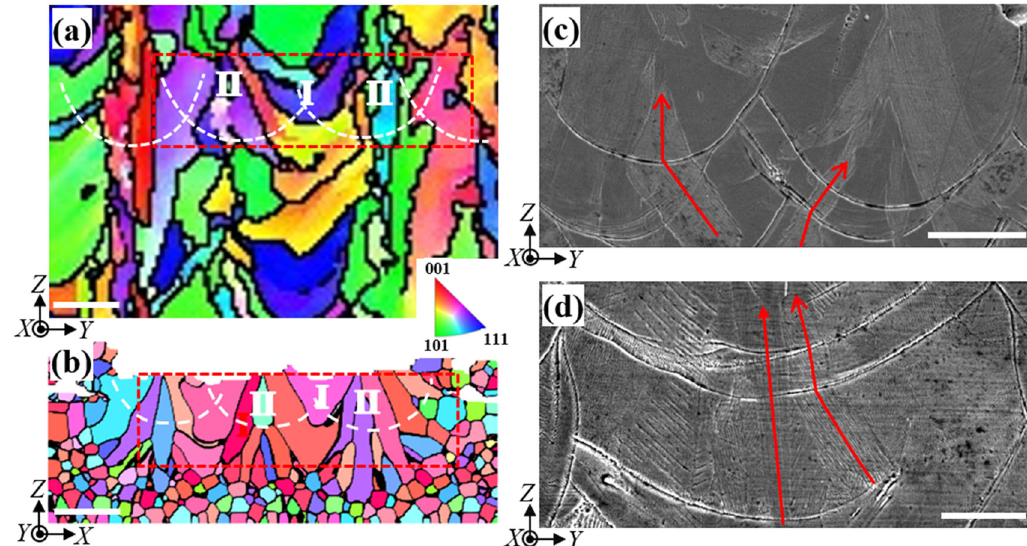
Fig. 5 Grain morphology in the as-built sample. a EBSD mapping; b simulation result after scanning of the 3 rd layer 3 rd track; c , d SEM images. The white dashed curves in a and b denote the estimated molten pool boundaries. The red arrows in c and d indicate the grain growth directions. Z direction is the build direction. Scale bars, 50 µm in a , b , 40 µm in c and 20 µm in d